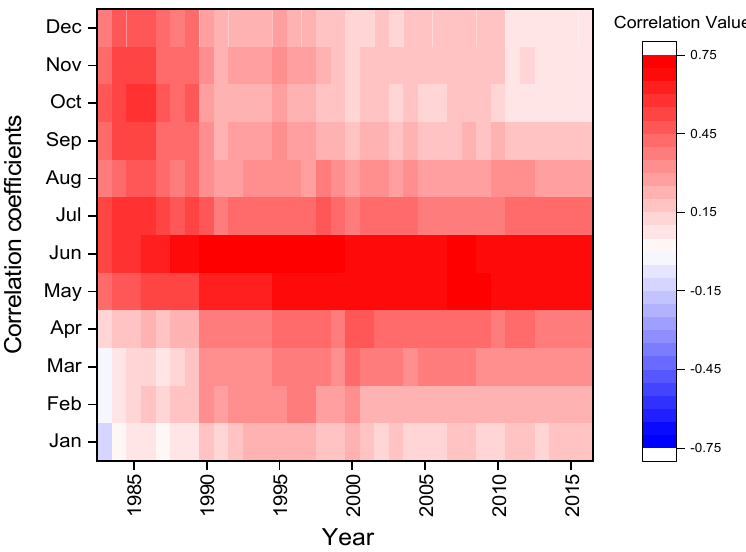
Figure 6. The moving correlation results of regional mean scPDSI MJ based on 24 baselength.